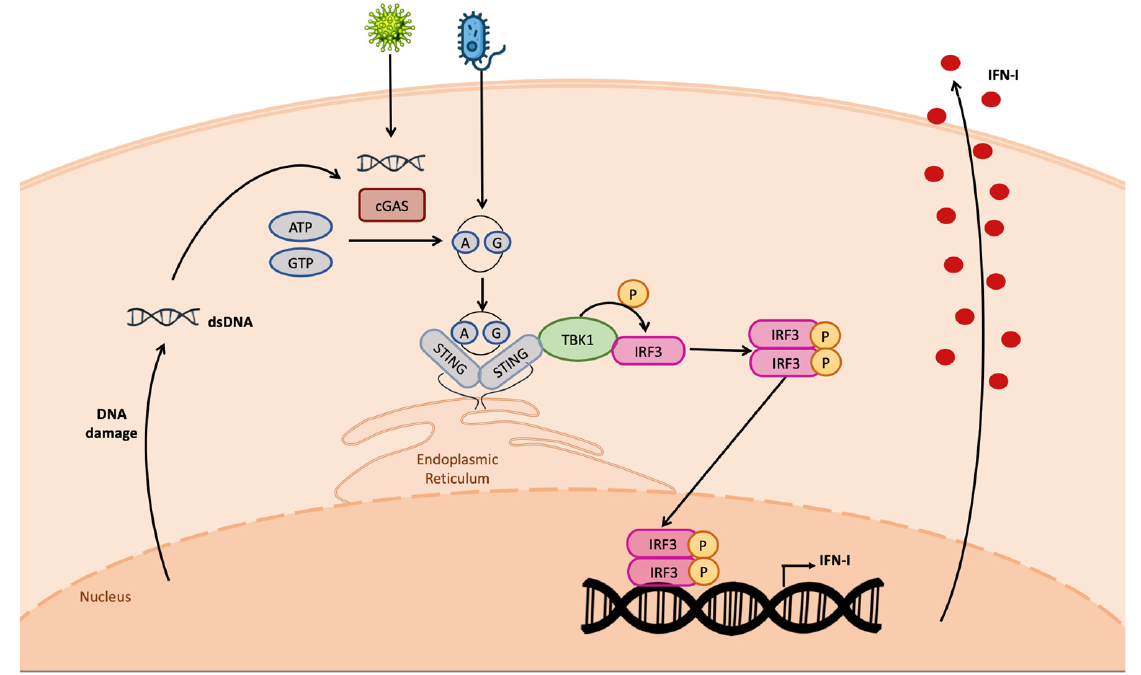
Figure 2. cGAS–STING pathway. The cGAS protein detects cytosolic DNA, leading to the production of CDNs. Both cellular- and bacterial-derived CDNs bind STING, leading to the activation of TBK1 kinase activity on IRF3. Phospho-IRF3 dimer enters the nucleus, binding the IFN-I promoter, inducing IFN-I transcription. IFN-I is produced and secreted outside the cell.